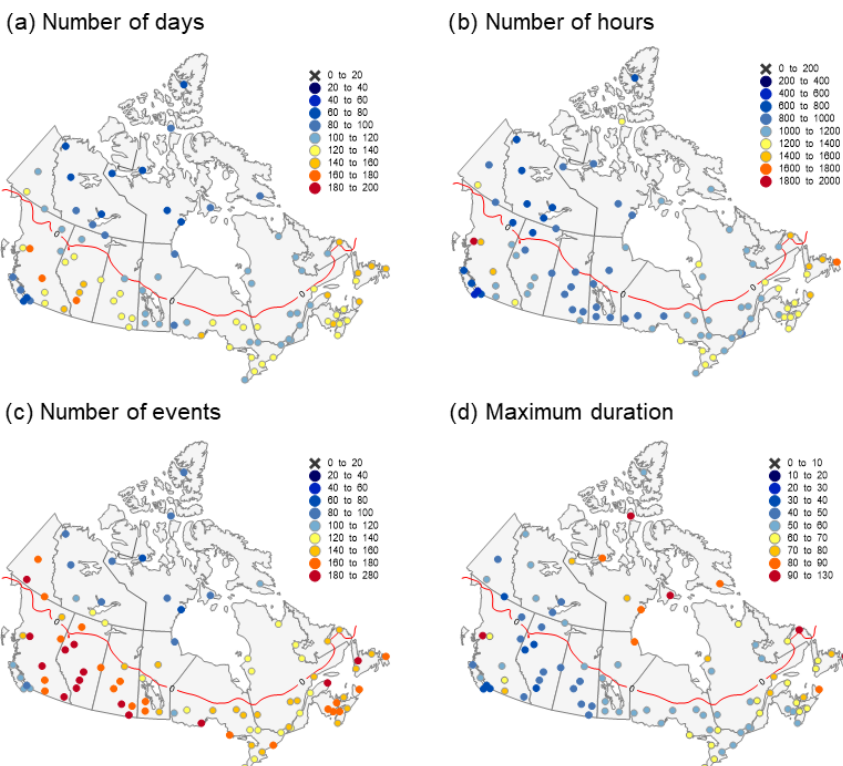
Figure 3. Average near-0 ◦ C ( − 2 ≤ T ≤ 2 ◦ C) conditions over the 1981–2011 period for (a) the number of days per year, (b) the number of hours per year, (c) the number of events per year, and the (d) annual maximum (max) duration of events. The red line indicates the annual average 0 ◦ C surface temperature computed from the 1981 to 2010 climate normals (ECCC,